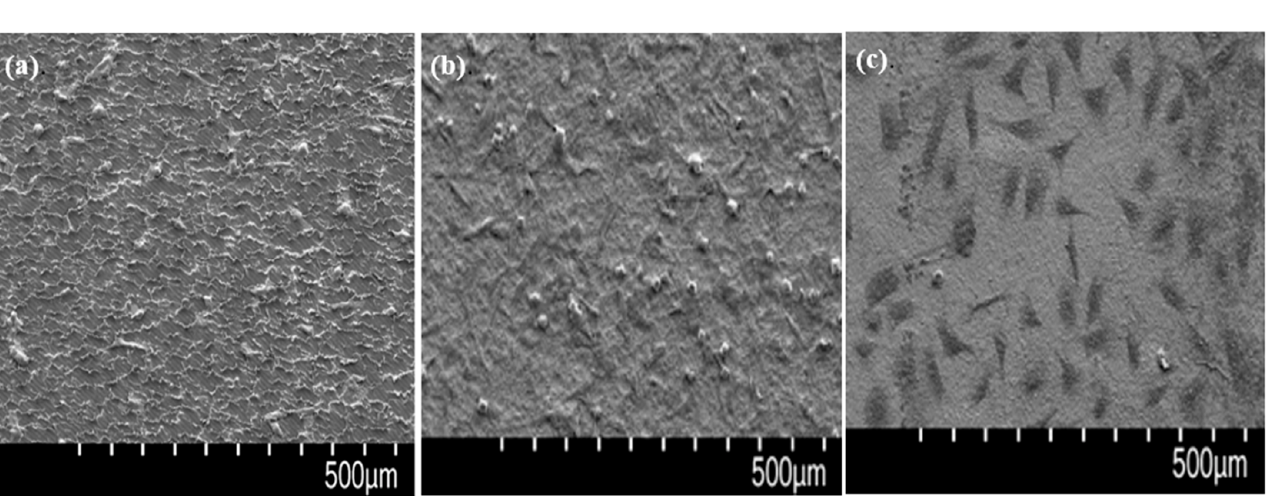
Alizarin red staining reveals the transformation of undifferentiated MC3T3-E1